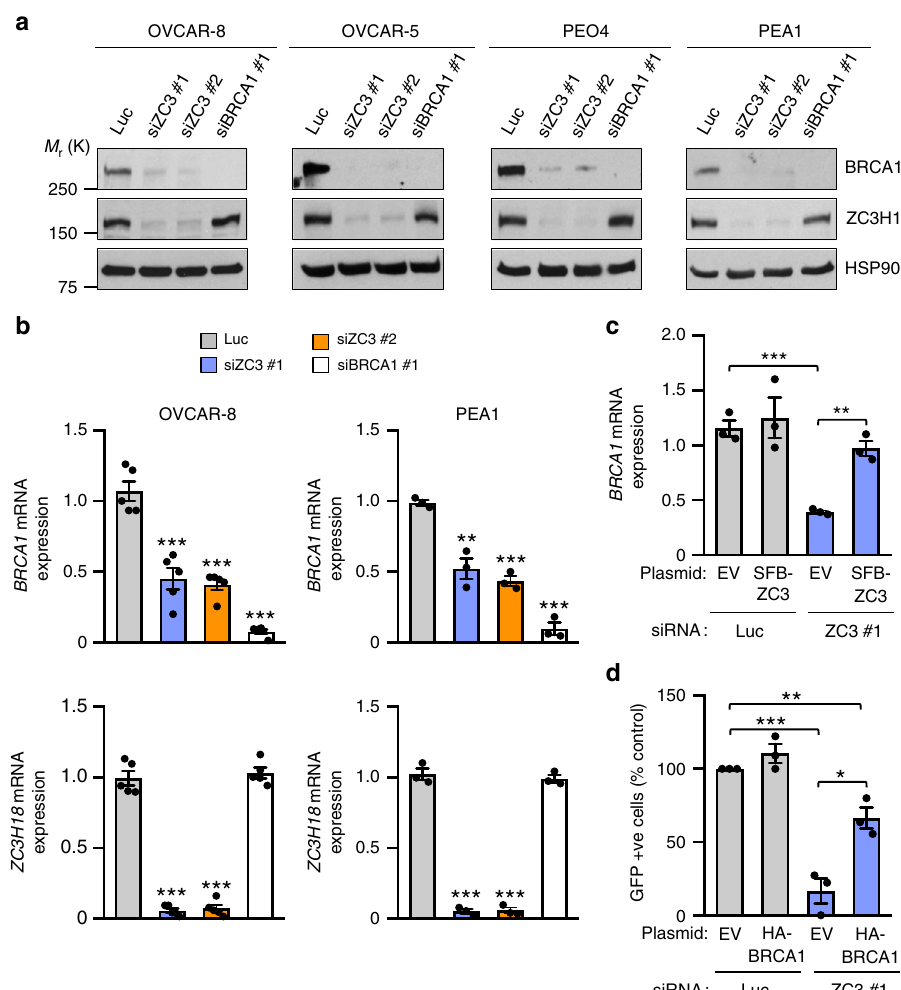
Fig. 2 ZC3H18 depletion reduces BRCA1 mRNA and protein levels. a and b Indicated cell lines were transfected with control luciferase (Luc), ZC3H18 (ZC3), or BRCA1 siRNAs. Forty-eight hours after transfection, the cells were immunoblotted for the indicated antigens ( a ) and analyzed by qRT-PCR for ZC3H18 and BRCA1 mRNA levels, which are expressed relative to GAPDH mRNA levels as an internal control ( b ). c Rescue of BRCA1 mRNA and protein in ZC3H18-depleted OVCAR-8 cells with siRNA-resistant SFB-ZC3H18. OVCAR-8 cells were transfected with Luc or ZC3H18 siRNA plus empty vector (EV) or siRNA-resistant ZC3H18 plasmid (SFB-ZC3H18). BRCA1 mRNA and proteins levels were assessed by qRT-PCR ( c ) and immunoblotting (Supplementary Fig. 4b), respectively. d Ectopic BRCA1 expression rescues the HR defect caused by ZC3H18 depletion. OCVAR-8 DR-GFP cells were transfected with empty vector (EV) or HA-BRCA1-expressing plasmid with either control luciferase (Luc) or ZC3H18 (ZC3) siRNAs. Seventy-two hours later, the cells were analyzed for GFP by fl ow cytometry. Representative immunoblots in a are provided from three independent experiments. Unprocessed blots are provided in Source data fi le. Shown are means ± SEM from three independent experiments in b – d . * p < 0.05, ** p < 0.01, *** p < 0.001, unpaired Student ’ s t-